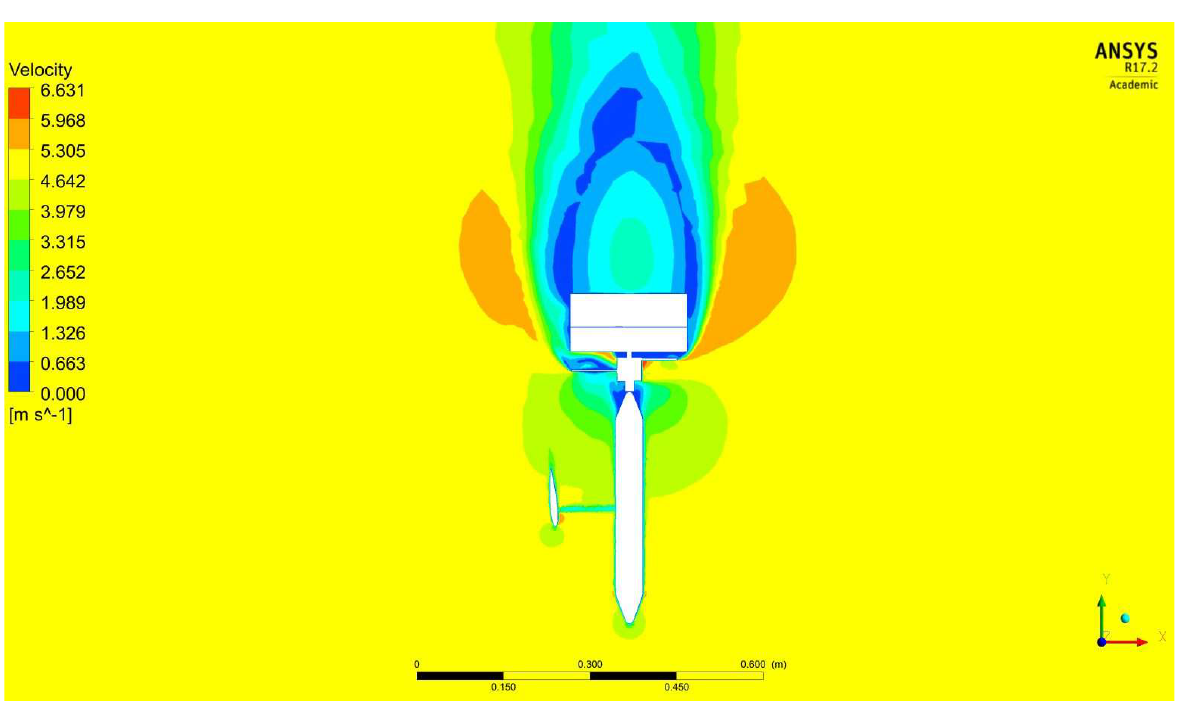
Figure 38. A planar view-based representation velocity variations on advanced US with horizontal fins—low speed altitude increment operation.